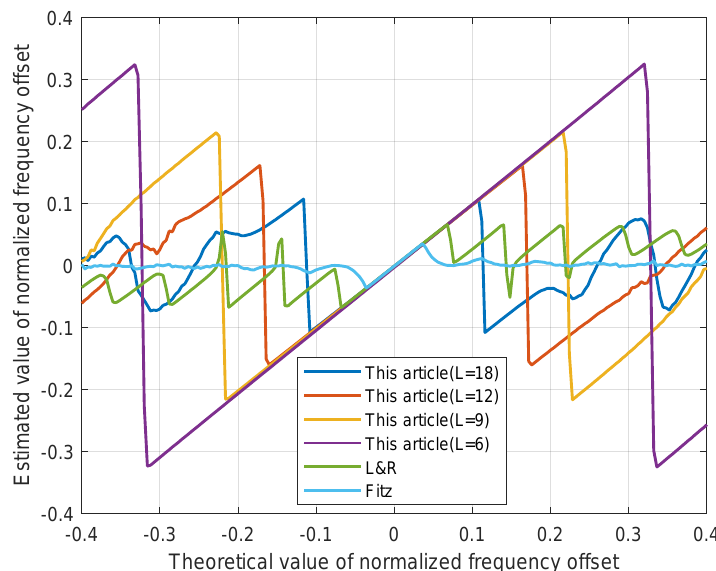
Figure 3. Estimation range of different frequency offset estimation algorithms.